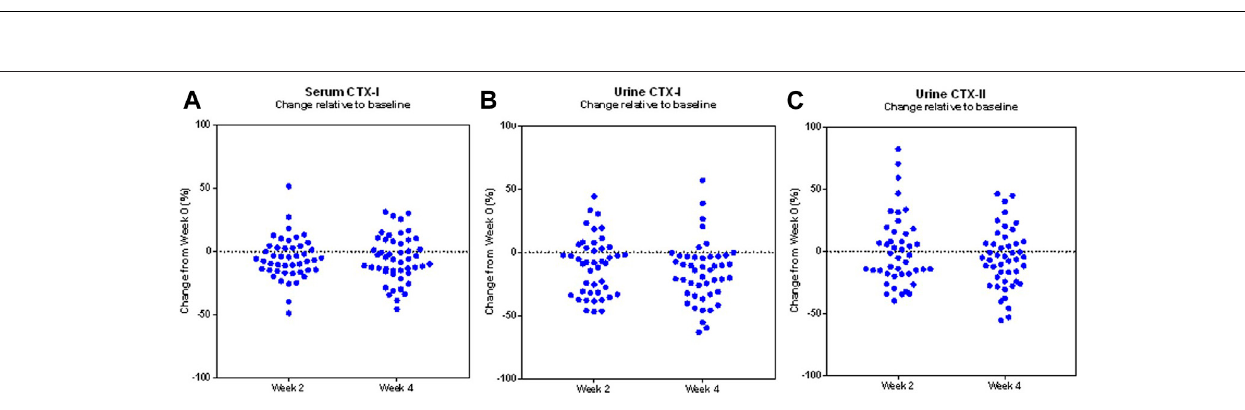
FIGURE 3 | Changes in biomarkers of bone and cartilage turnover in the study population. Scatter plot of the individual proportional changes from baseline in the biomarkers serum CTX-I (A) , urine CTX-I (B) , and urine CTX-II (C) , during the trial in the modi fi ed Intention-to-treat population ( N (cid:1) 49). Each data point represents the corresponding change from baseline of one study